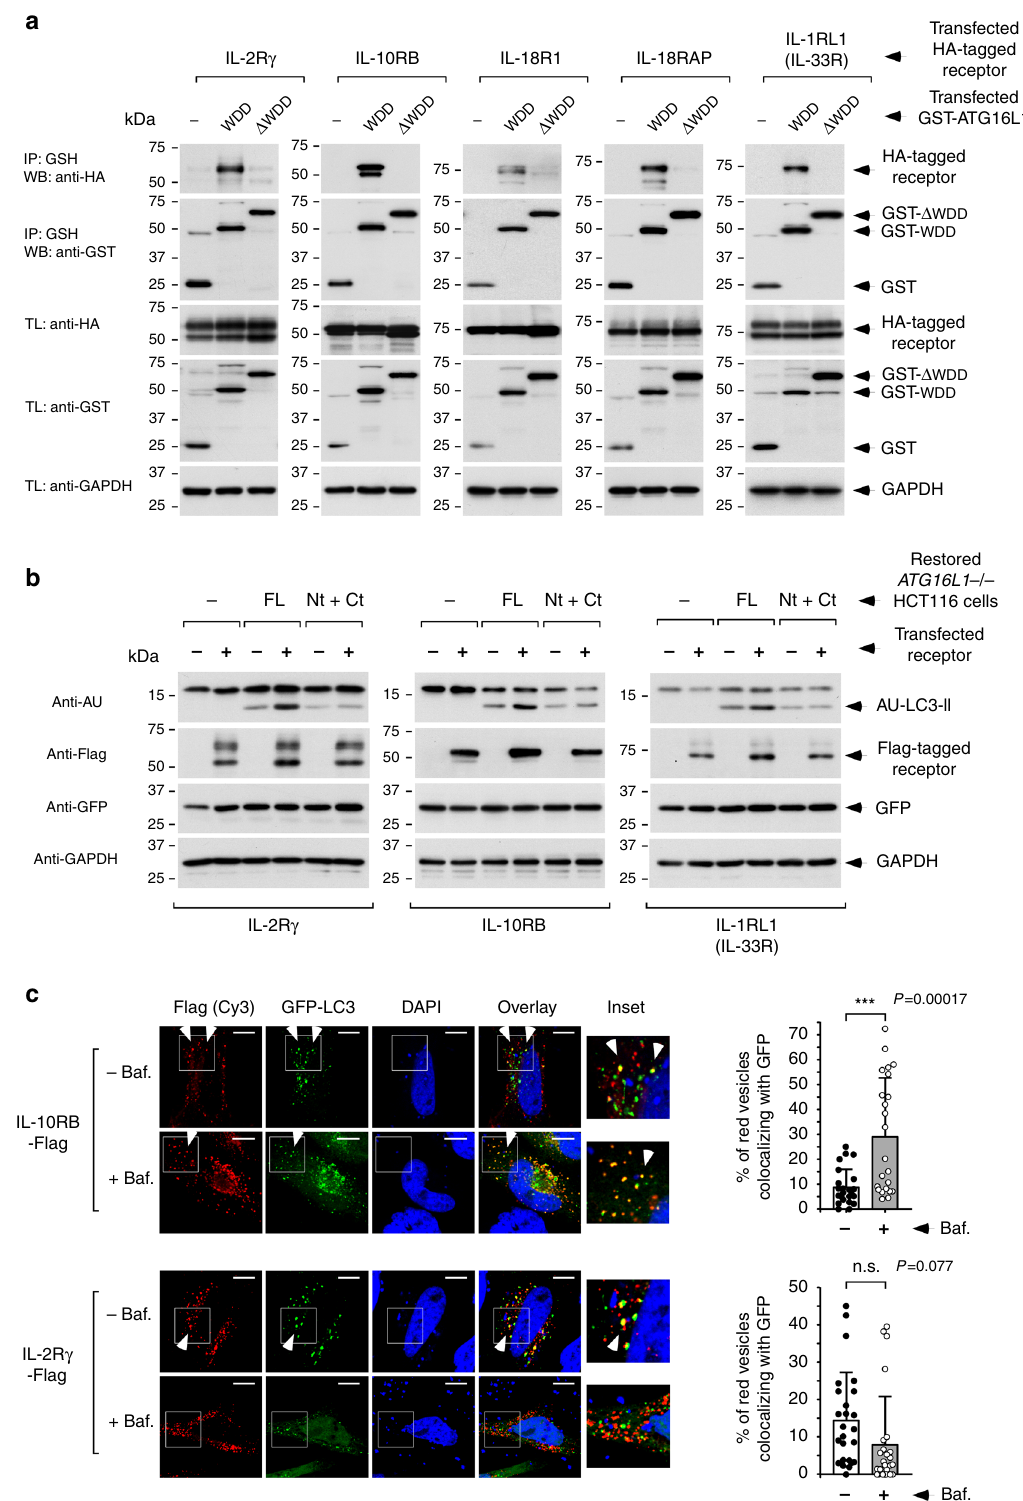
pointing to a defect in endocytosis and/or traf fi cking of IL-10/IL- 10R complexes in the absence of the